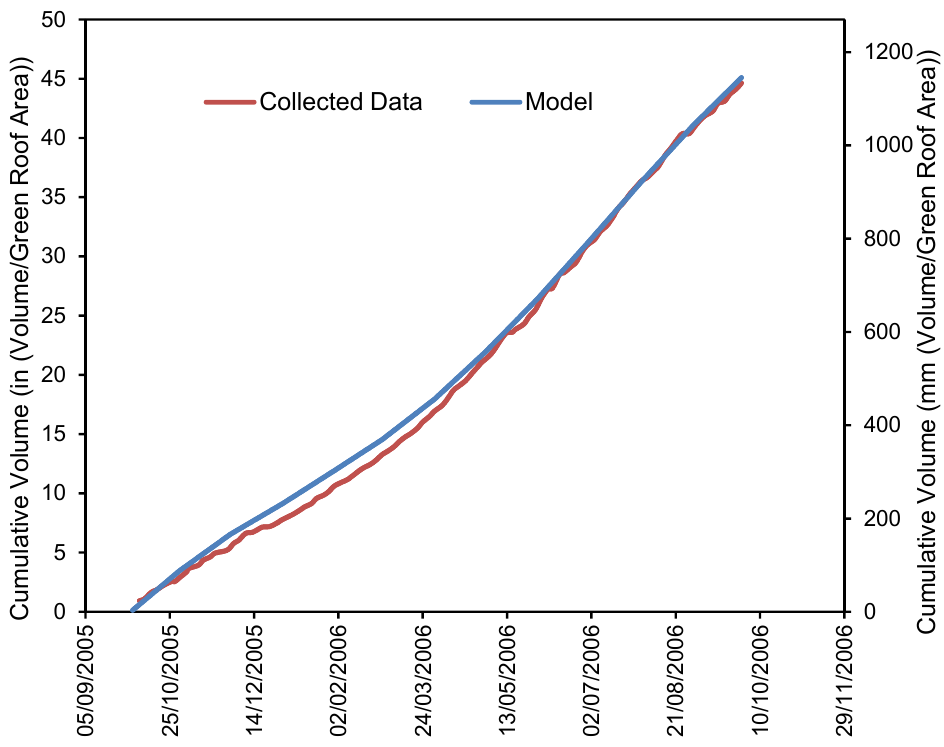
Figure 3. Comparison of cumulative ET volume for the Blaney and Criddle equation and actual data collected from experimental chambers [10].